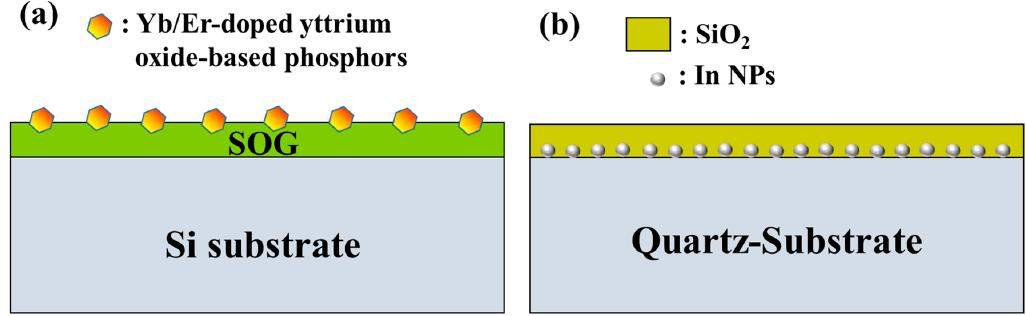
Figure 1. Schematic diagram of the test sample with ( a ) up-conversion (UC) layer and ( b ) SiO 2 layer with embedded indium nanoparticles (In NPs).